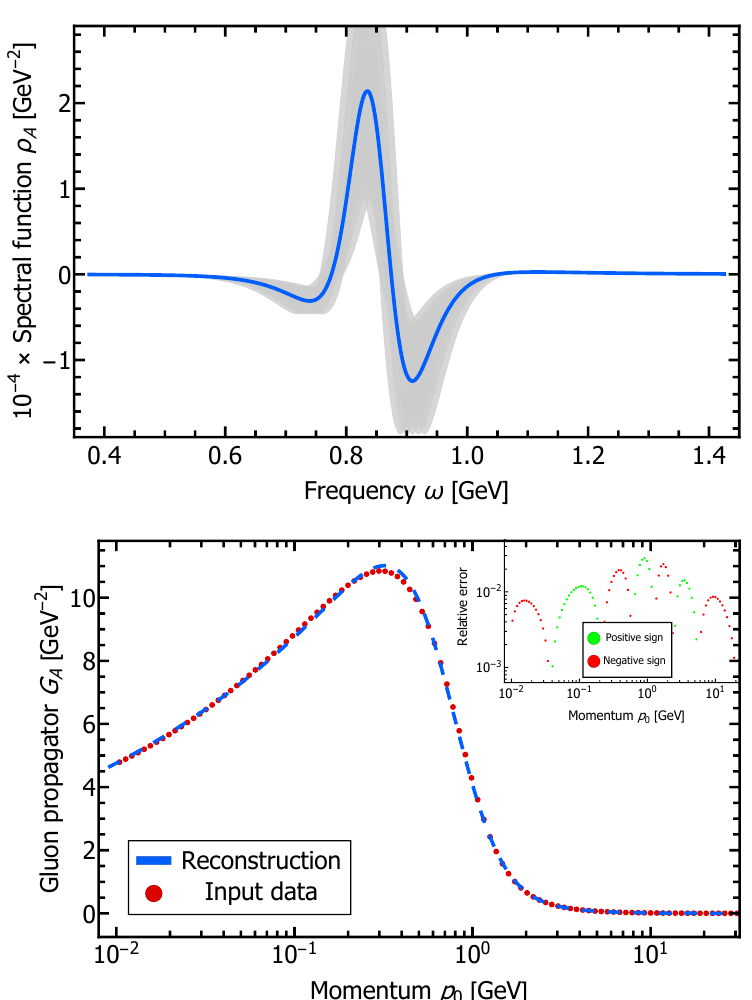
Figure 6: Top: Gluon spectral function. The solid blue line shows our best result. The gray band around it indicates our estimate for the systematic error. Bottom: Gluon propagator reconstructed from the spectral function shown in Figure 7 in comparison to the original